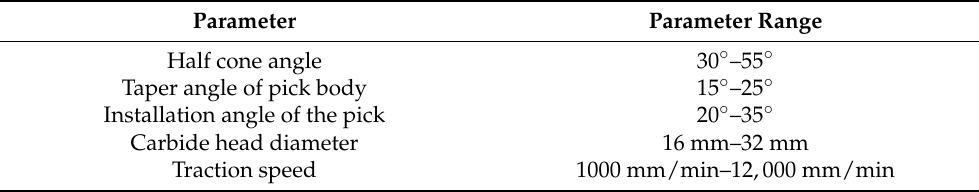
Table 3. Range of the design